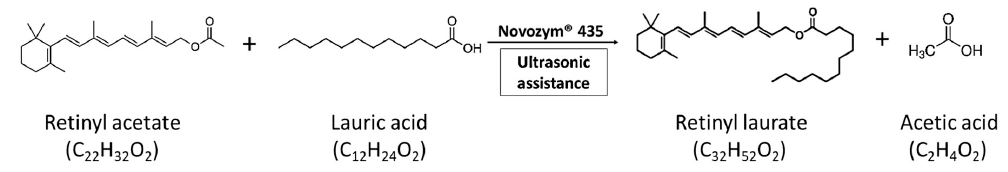
Figure 1. The reaction diagram of ultrasound-assisted retinyl laurate synthesis catalyzed by Novozym ® 435. Figure 1.